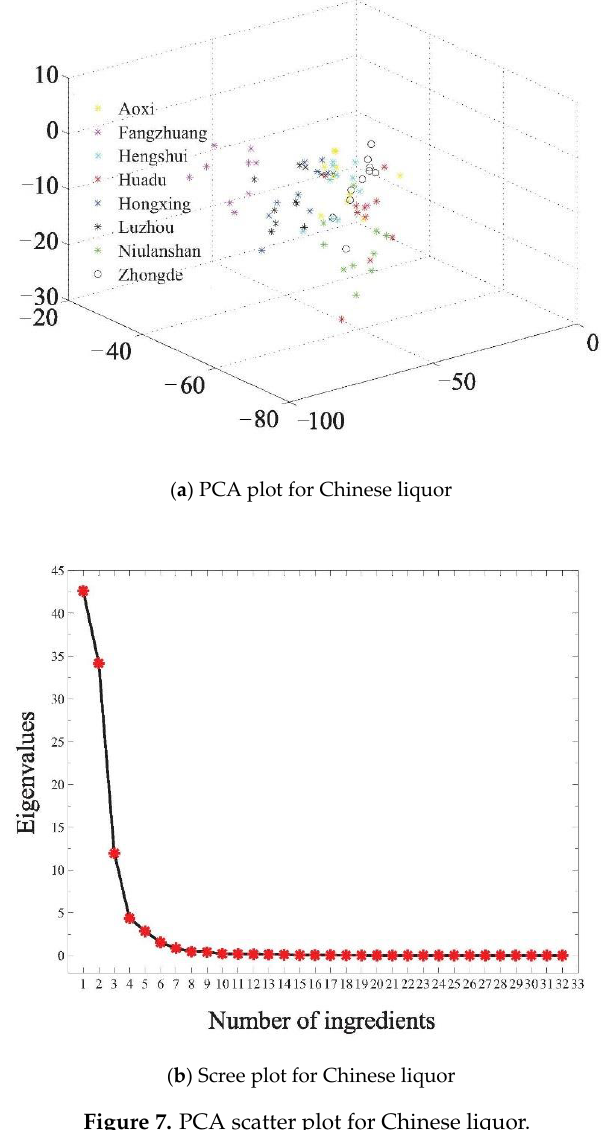
Figure 7. PCA scatter plot for Chinese liquor.